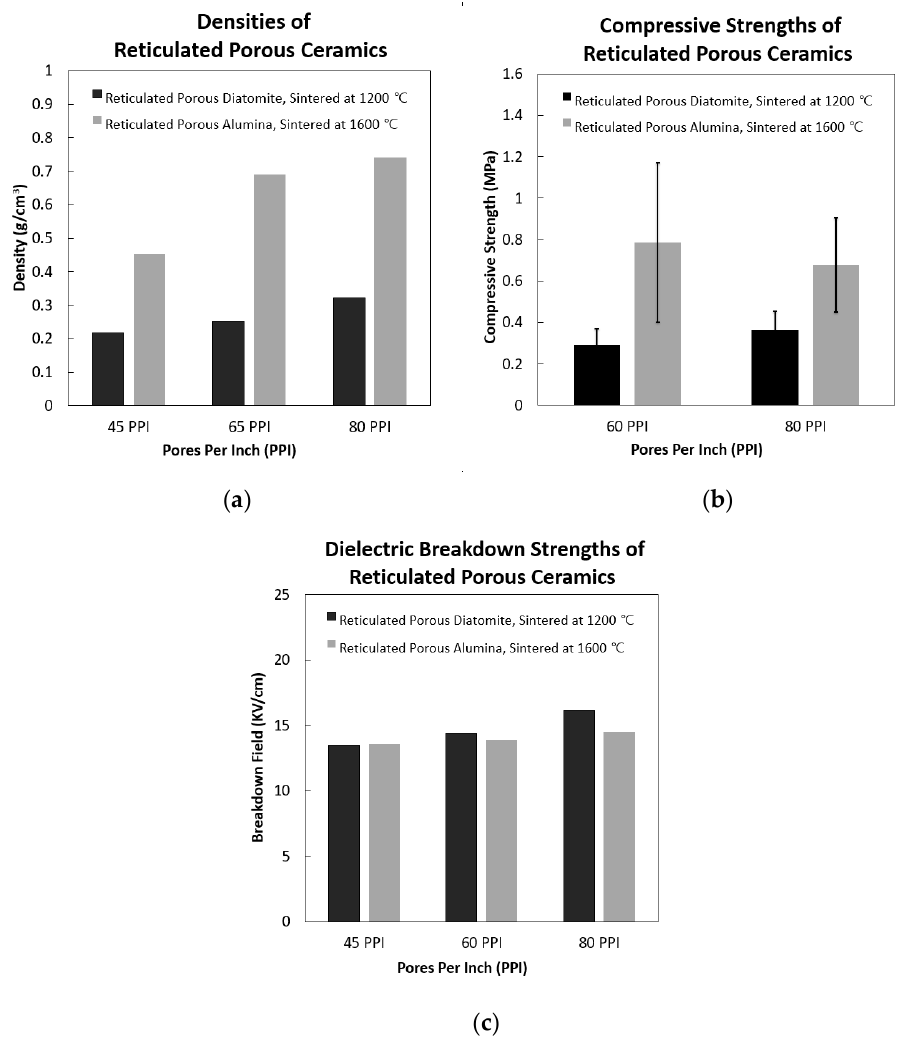
Figure 7. ( a ) Densities of reticulated porous diatomite-kaolin composite and reticulated porous alumina specimens, with pore densities of 45, 60, and 80 PPI. ( b ) Compressive strengths of reticulated porous diatomite-kaolin composite and reticulated porous alumina specimens, with pore densities of 60 and 80 PPI. ( c ) Dielectric breakdown strengths of reticulated porous diatomite-kaolin composite and reticulated porous alumina specimens, with pore densities of 45, 60, and 80